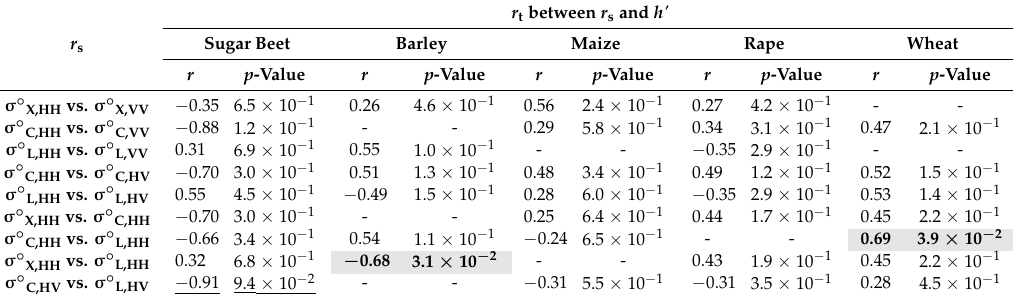
Table 8. r t vs. h’ temporal correlations, r t , over the whole period for different crops; significant strong correlations ( p -value < 0.05, 0.6 < r < 0.8) are in light-gray highlighted with values in bold; quasi -significant correlations (0.05 < p -value < 0.1) are outlined; very weak correlations ( r < 0.19) are not